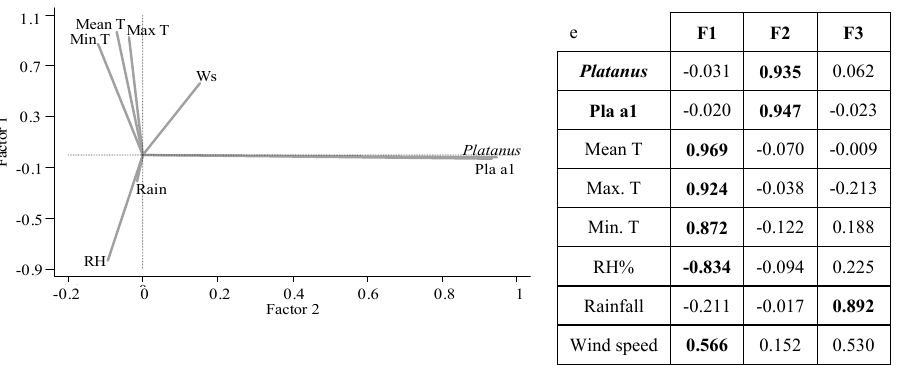
Figure 3. Plot and Factors of principal components and factor analysis (PCFA) for each taxon, meteorological parameters: Mean, Maximum and Minimum temperatures (Mean T, Maximum T and Minimum T), Relative humidity (RH), Rainfall (Rain) and Wind speed (Ws) (a- Fraxinus . b- Alnus . c- Platanus . d- Betula and e- Olea ).